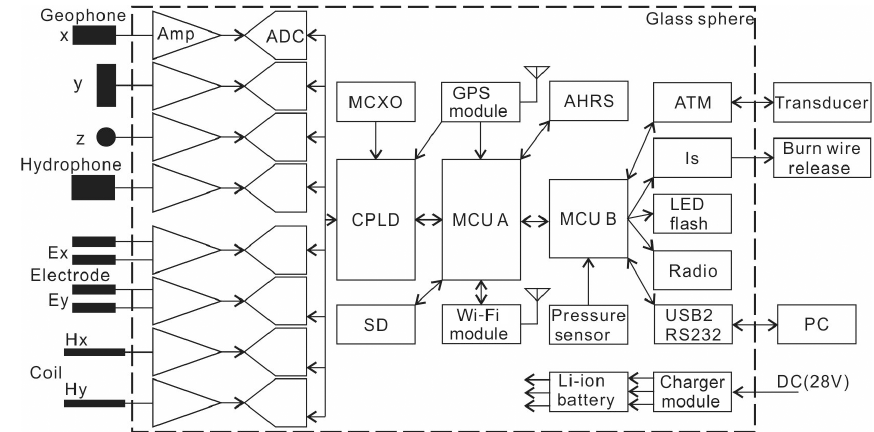
Figure 3. Circuit diagram of the OBEMS data logger, containing EM and seismic sensors, eight amplifiers, eight analog-to-digital convert- ers (ADC), a complex programmable logic device (CPLD), secure digital memory card (SD), microprocessor controlled crystal oscillator (MCXO), Li-ion rechargeable battery, charger module, LED flash, radio, ATM, and attitude and heading reference system (AHRS). In this preliminary design, the ATM, burn wire release, ultra-short base line (USBL), and relay release are all designed for release.